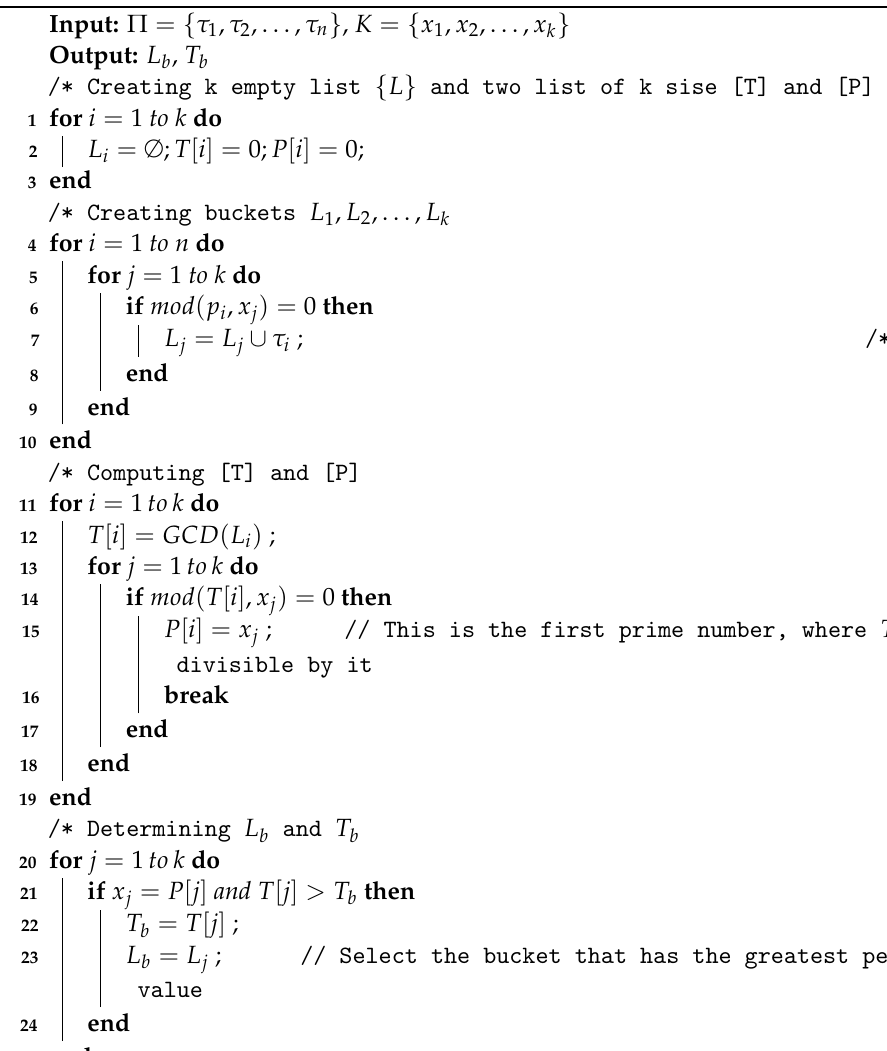
Algorithm 4: Bucket select